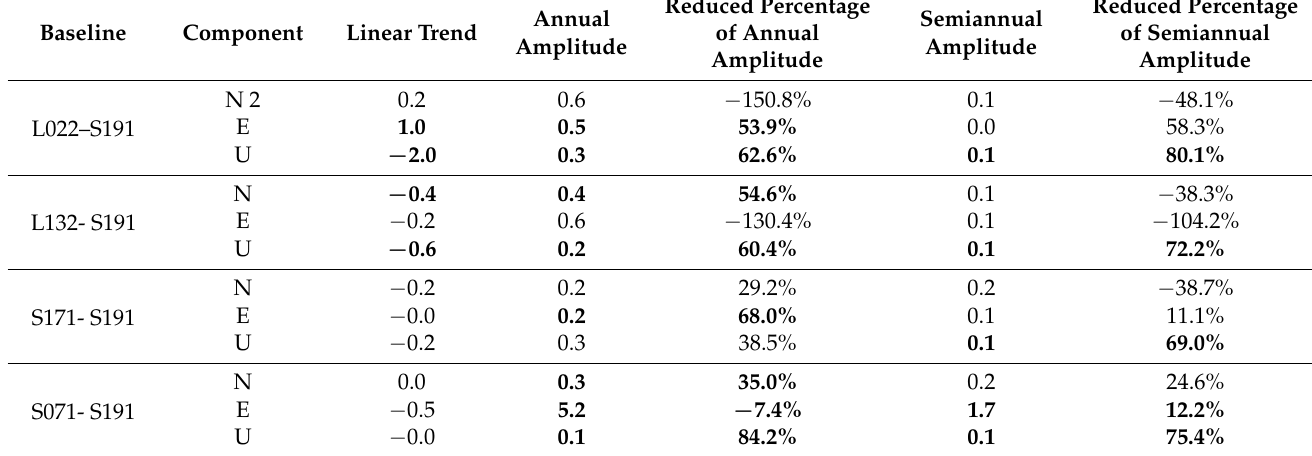
Table 5. Linear trend and annual and semiannual amplitude estimations (mm). Percent 1 and 2 indicate the annual and semiannual, respectively, amplitude-reducing percentage of station–S191 with respect to station–TN02. The figures in bold are the bold components in Table